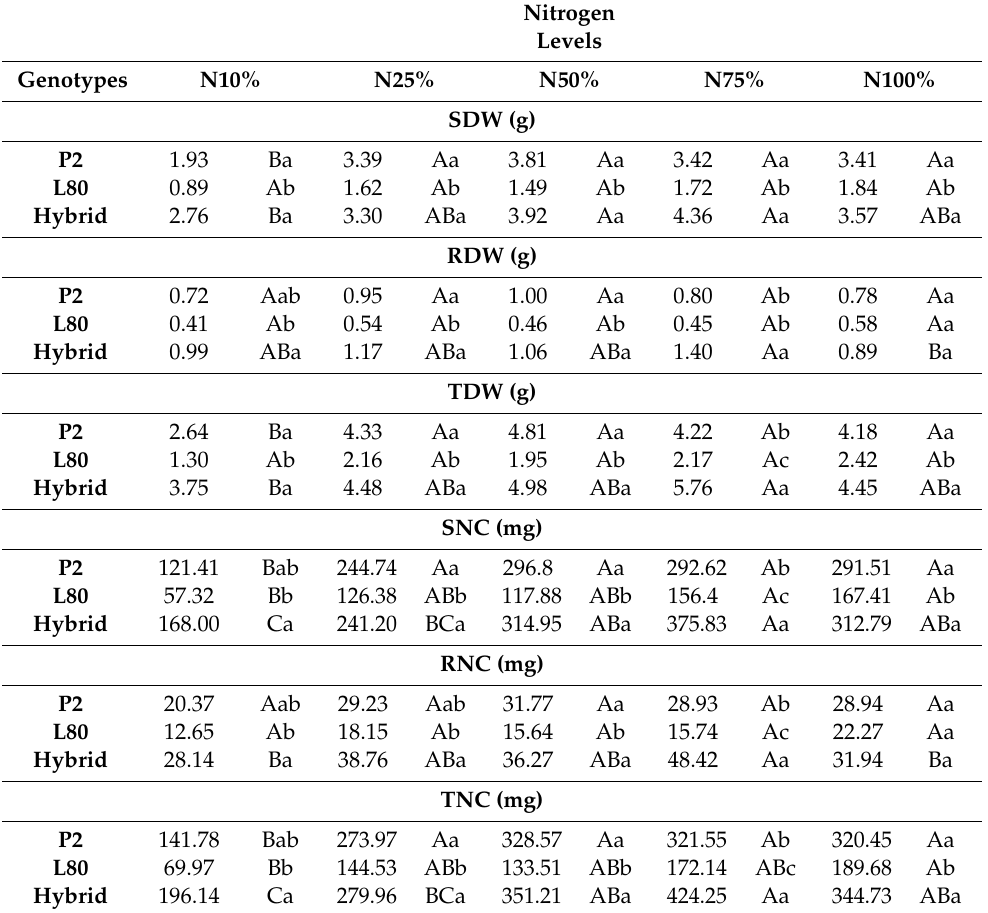
Table 2. Mean values of popcorn genotypes for the shoot, root, total dry weight, and N content under five di ff erent N levels at the V6